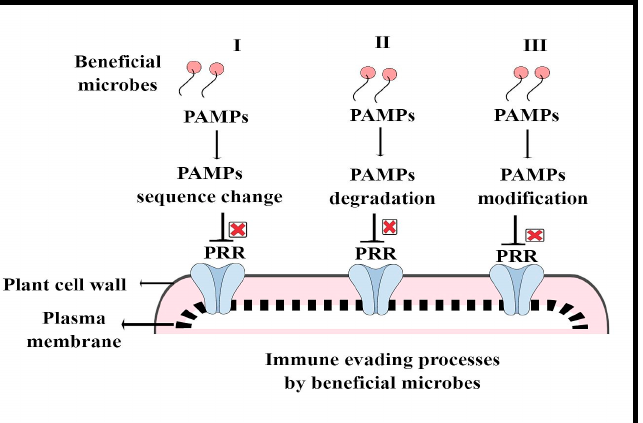
Figure 3. How beneficial microbes evade the plant immune system: (I) PAMPs sequence change; (II) PAMPs degradation; (III) PAMPs modification.